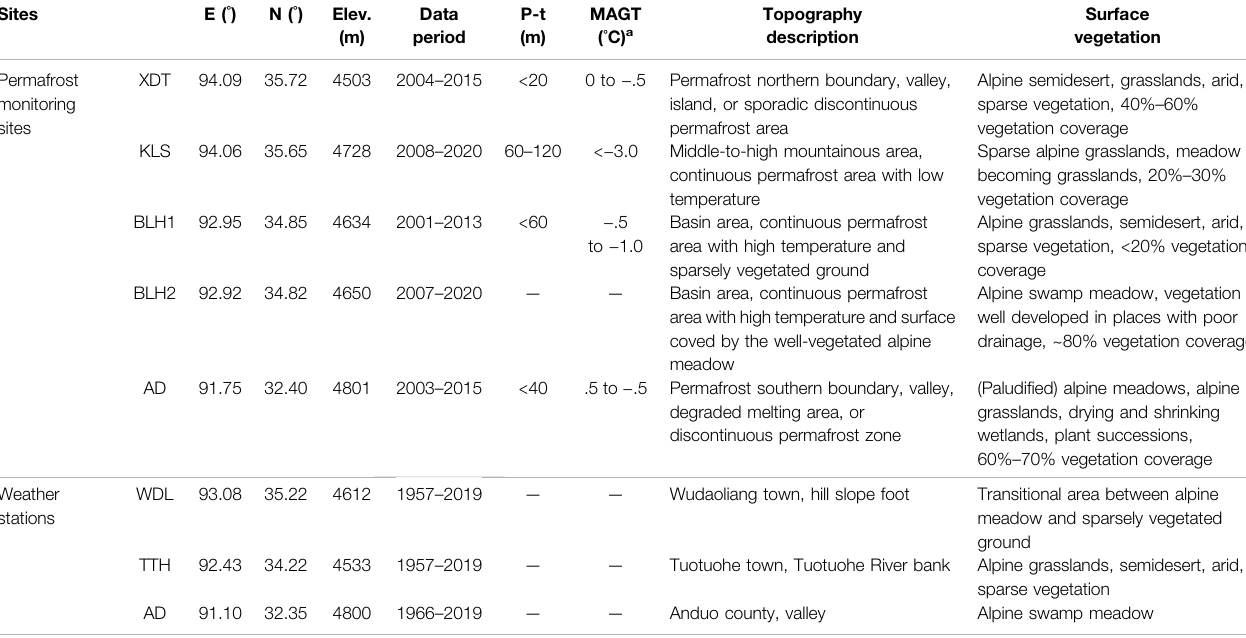
TABLE 1 | Locations of permafrost monitoring sites and weather stations and their surface conditions in the study region [P-t: permafrost thickness (m)].